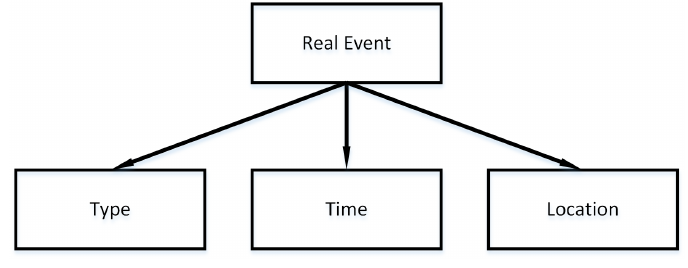
Figure 1. Real event parameters.